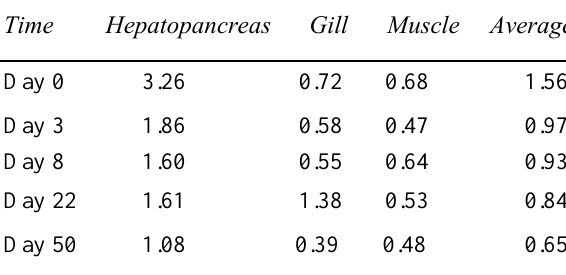
Table 5 : Total arsenic concentrations from final bioconcentration day to final depuration day, 3.42 ppm + surfactant treatment